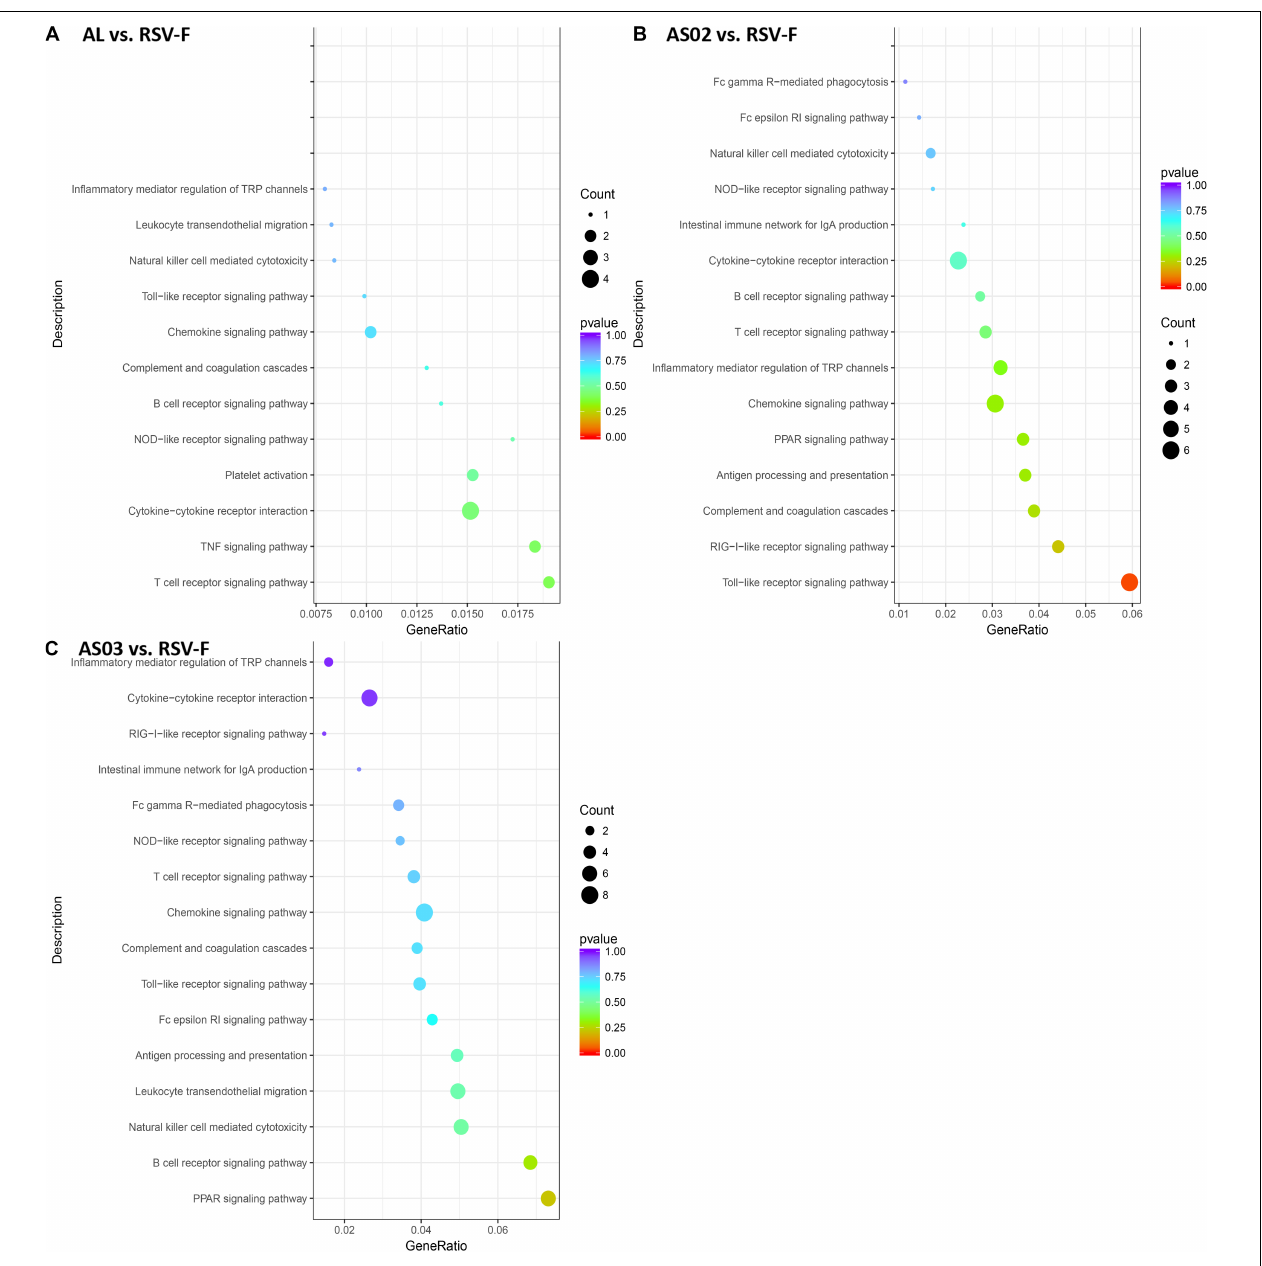
FIGURE 10 | DEG KEGG pathway enrichment after vaccination. DEGs (A) Al vs. RSV-F, (B) AS02 vs. RSV-F, and (C) AS03 vs. RSV-F were used for KEGG pathway analysis using the DAVID functional enrichment database. The x -axis is GeneRatio (The ratio of KEGG pathway-annotated genes to the total DEG number). The y -axis shows the KEGG pathway. Point size represents the number of DEGs associated with each term. Color reflects the enriched pathway significance